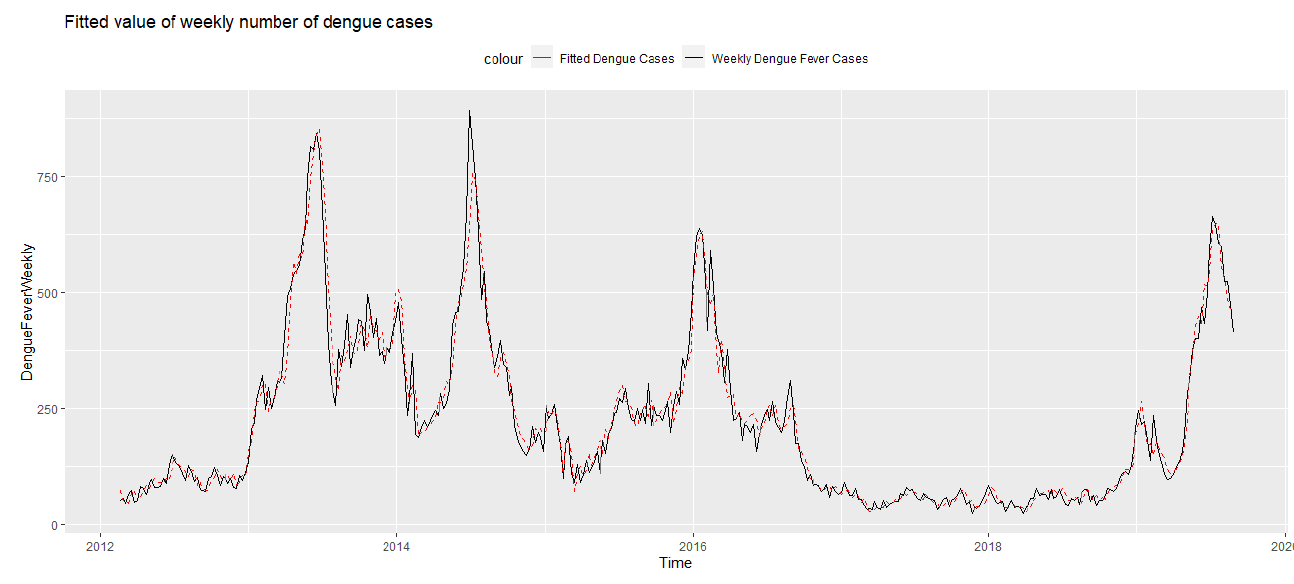
Figure 2. The estimated number of dengue cases (DLNM with wind speed) juxtaposed against the original dengue time series.